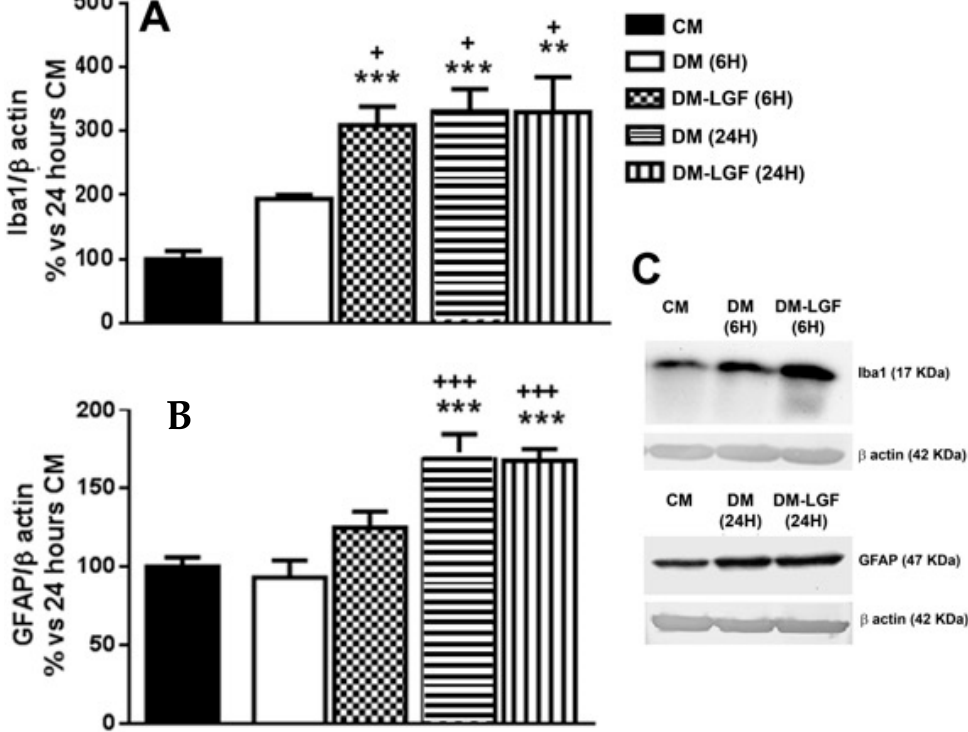
Figure 3. Liver growth factor (LGF) modulated Iba1 protein expression in cultured mesencephalic glia. ( A ) shows how 100 pg / mL of LGF treatment up-regulated Iba1 protein expression after 6 h (dots